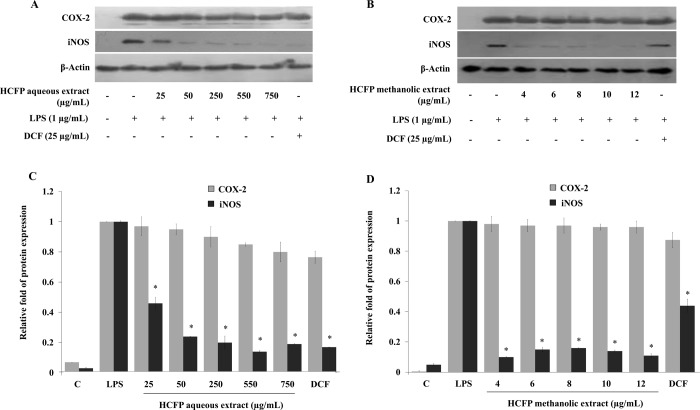
Effect of aqueous (A) and methanolic (B) extracts of HCFP on protein levels of iNOS and COX-2 in LPS-stimulated RAW264.7 cells. The cells were pre-treated with the indicated concentration of aqueous extract or phenolic extract for 2 h and then stimulated with LPS (1 μg/mL) for 24 h. The protein expression levels were analyzed by western blot. Bar graphs showed the relative fold of protein expression in aqueous- (C) and methanolic- (D) treated cells. Data were expressed as mean ± S.D. *p < 0.05 compared with the LPS group.